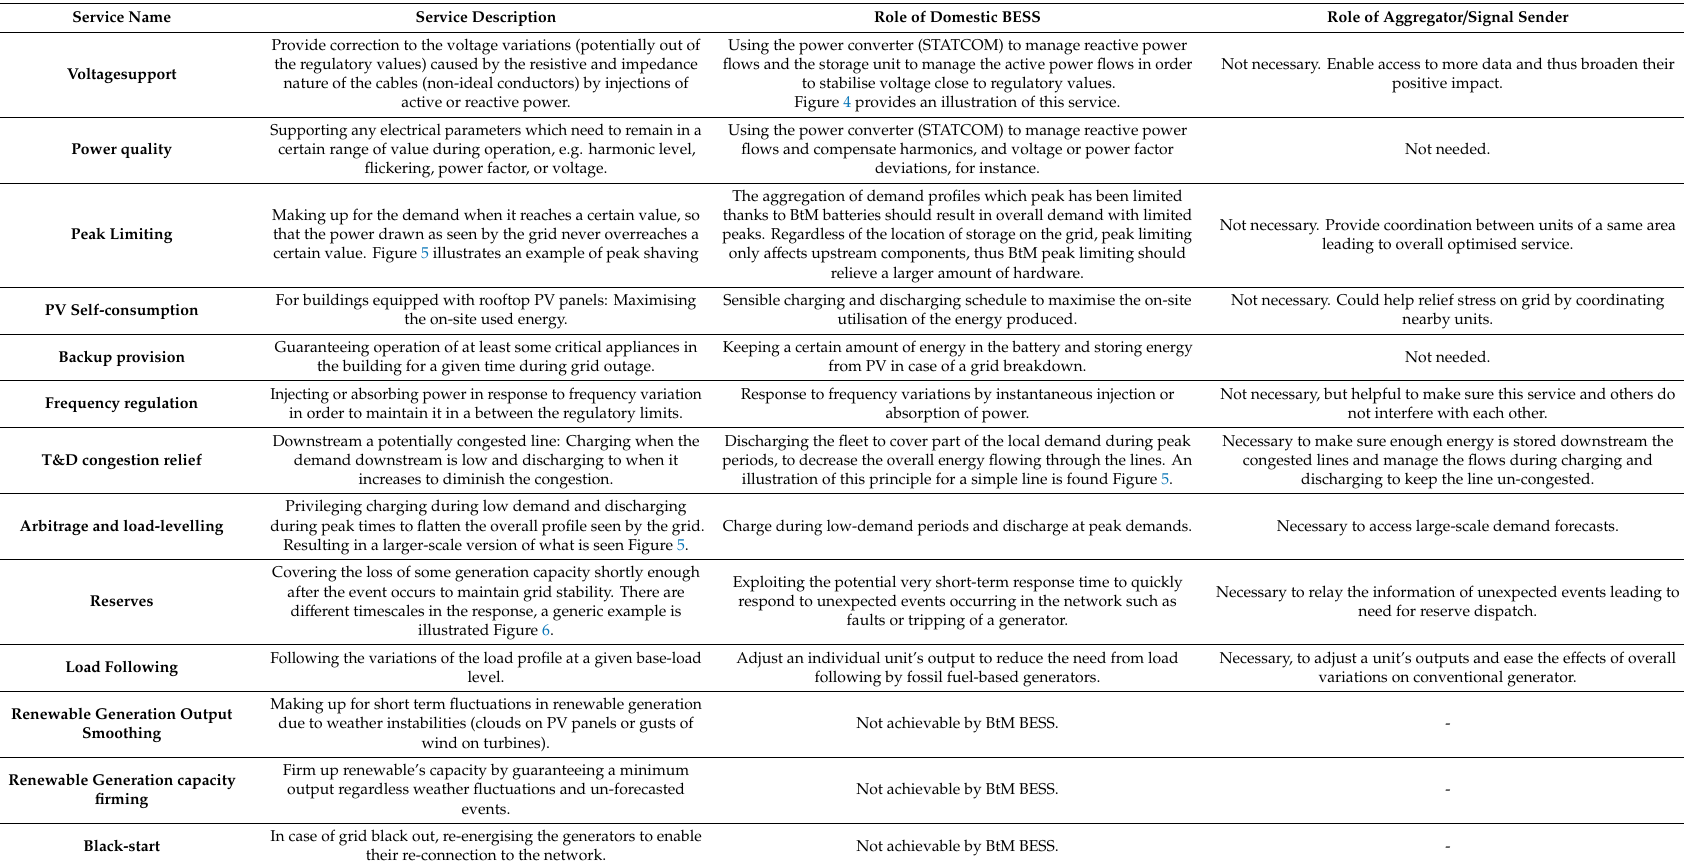
Table 4. Role of Behind-the-Meter Battery Energy Storage Systems in providing grid